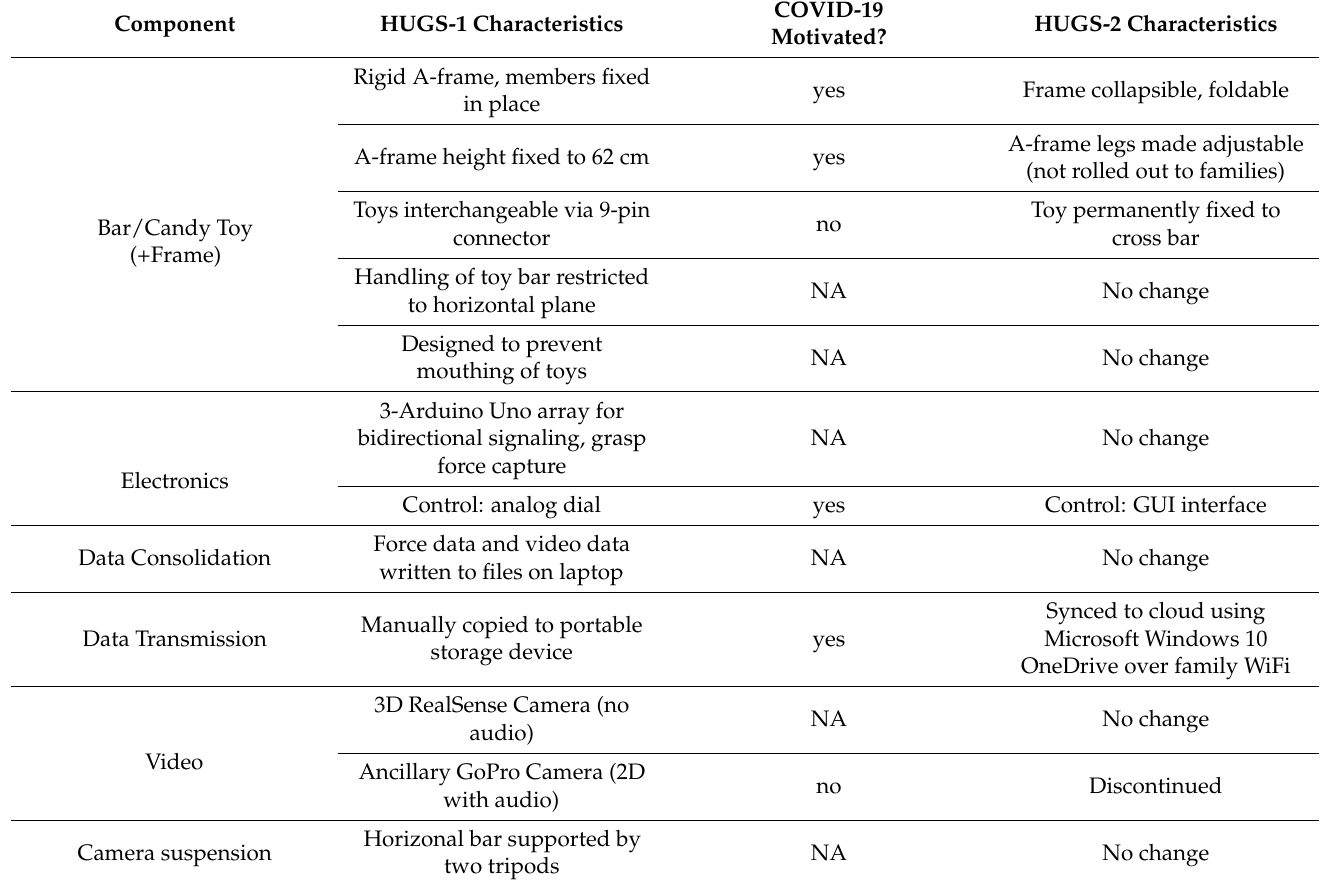
Table 2. HUGS evolution: summary design changes HUGS-1 to